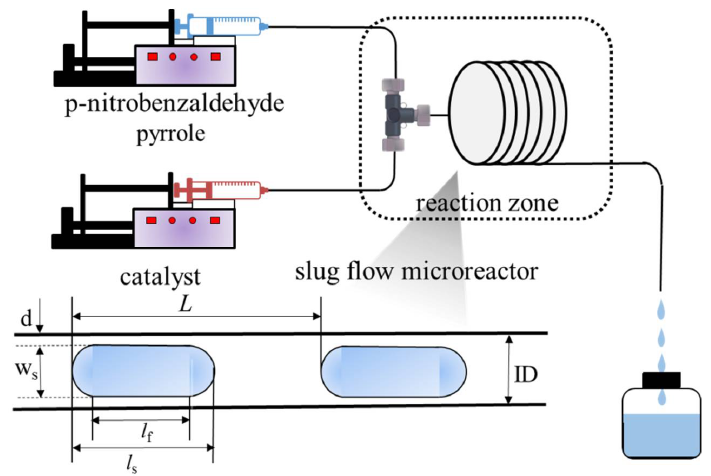
Figure 2. Schematic diagram for the continuous synthesis of 2,2′-(4-nitrophenyl) dipyrromethane in the liquid–liquid slug-flow microreactor.